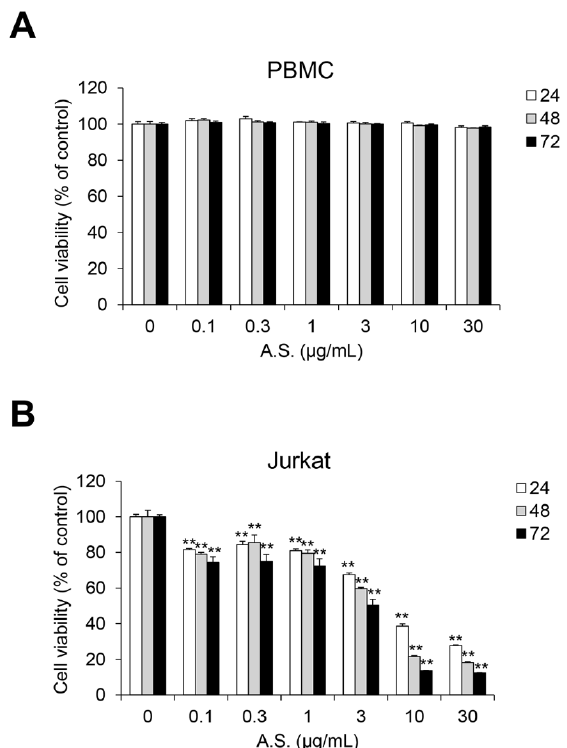
Figure 1. A.S. extract induces cell death in T-ALL Jurkat cells. Peripheral blood mononuclear cells (PBMCs) ( A ) and Jurkat cells ( B ) were incubated with Allium senescens L. extract (A.S.) (0–30 µ g/mL) for 24–72 h, and cell viability was measured. Experiments were performed in triplicate. Data are presented as mean ± SD. ** p < 0.01 (vs. control).